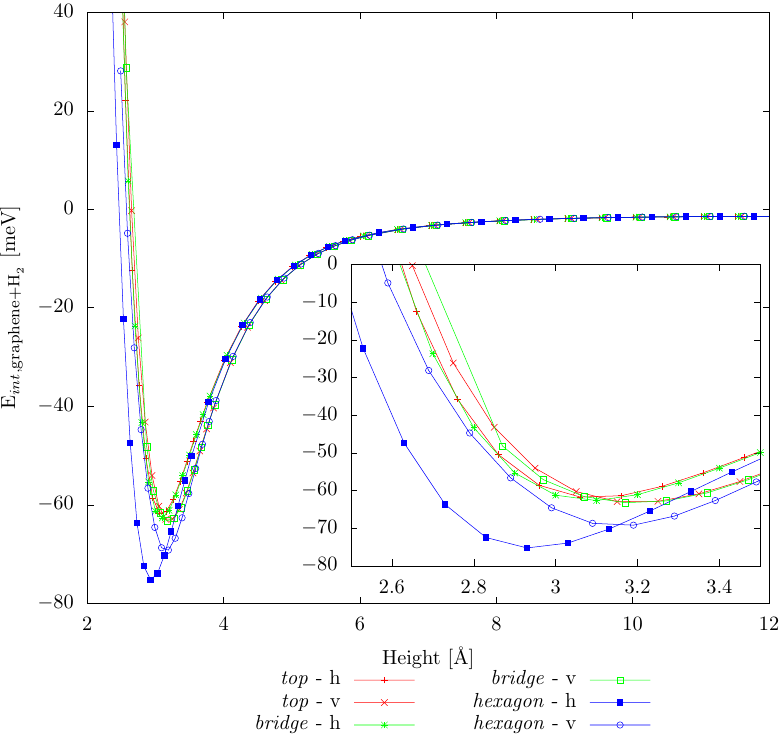
Figure 2. Interaction energy, E int , for two different alignments (horizontal, h, and vertical, v) of the H 2 molecule at three adsorption sites ( top , bridge , hexagon ) on